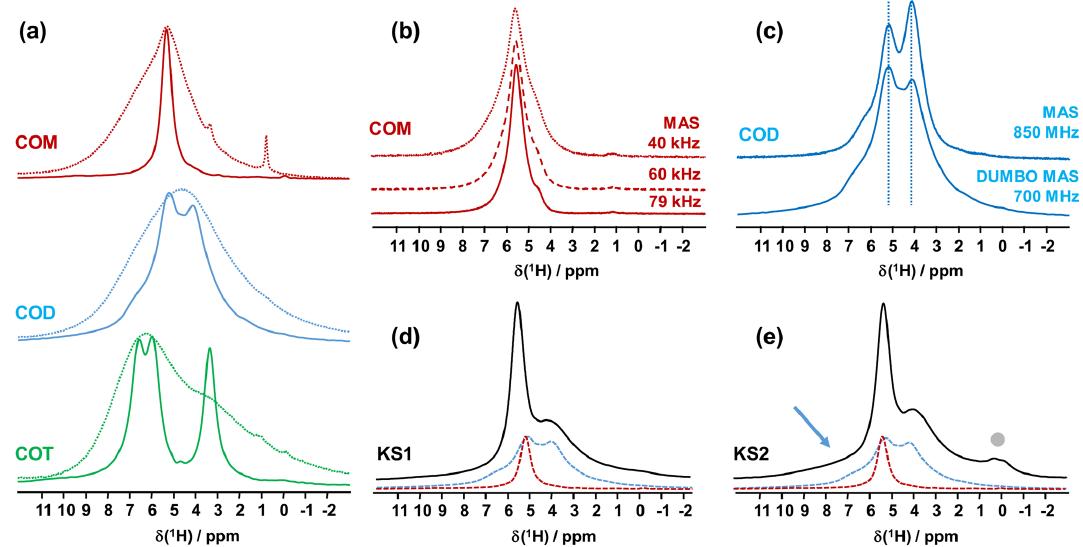
Figure 1. (a) 1 H MAS (dashed lines) and 1 H DUMBO MAS (solid lines) NMR spectra of COM (in red), COD (in blue) and COT (in green; ν rot = 12kHz, 700MHz, 16.4T). Only the isotropic resonances are represented. (b) 1 H very fast MAS (40, 60 and 79kHz) NMR spectra of COM at a very high magnetic field (850MHz). (c) Comparison of the 1 H NMR spectra of COD obtained under DUMBO MAS ( ν rot = 12kHz, 700MHz) and very fast MAS ( ν rot = 79kHz, 850MHz) conditions. Vertical dashed lines are for illustration purposes only. (d) 1 H DUMBO MAS NMR spectrum of KS1 ( ν rot = 12kHz, 700MHz). The red and blue dashed lines correspond to the experimental 1 H DUMBO MAS NMR spectra of COM and COD, respectively. (e) 1 H DUMBO MAS NMR spectrum of KS2 ( ν rot = 12kHz, 700MHz). The plain light gray circle indicates the presence of organic components in KS2. The blue arrow indicates the superposition of organic components (aromatic region) and the deshielded shoulder of